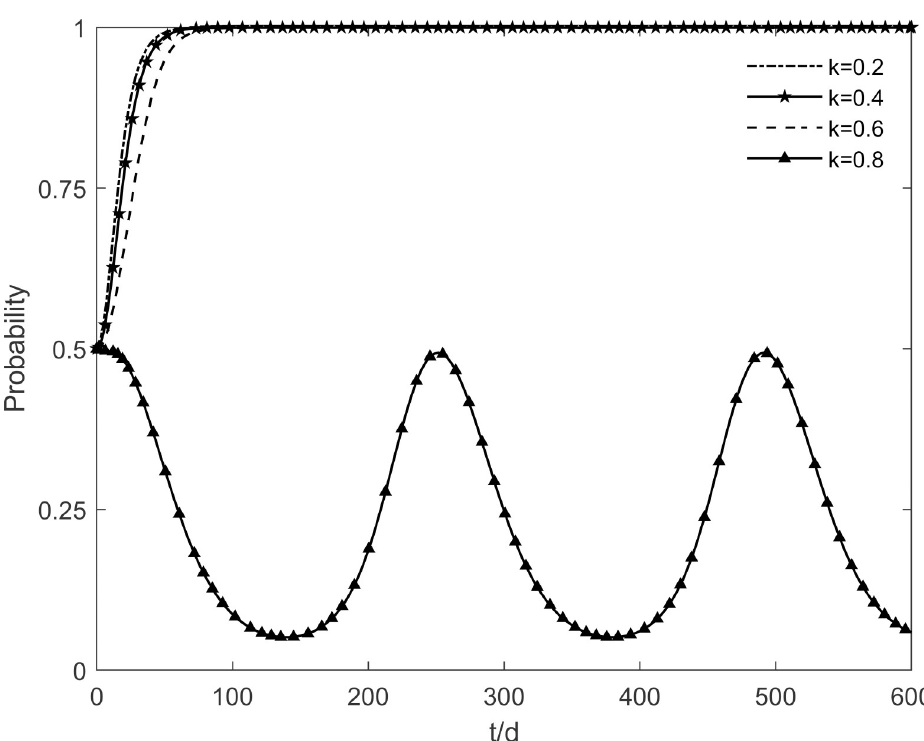
Fig 19. The impact of k on the investment retrofitting enterprises’ strategic choices.